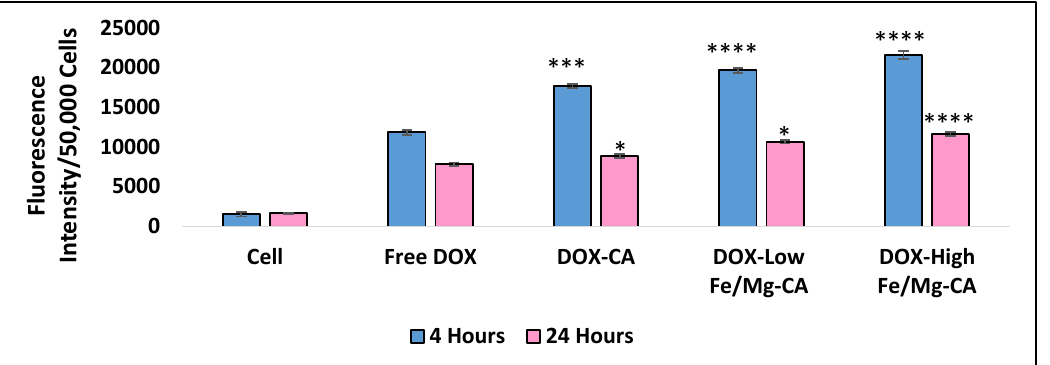
Figure 15. Fluorescence intensity measurement of free DOX, DOX-loaded low Fe/Mg-CA, DOX-loaded high Fe/Mg-CA and DOX-loaded CA particles in MCF-7 cells after 4 h and 24 h of treatment. Results were considered significant at p-value 0.01–0.05 (*), highly significant at p-value 0.0001–0.001 (***) and extremely significant at p-value ˂ 0.0001 (****). P values were calculated with respect to control (DOX in media) and treatment (DOX bound NPs). The confidence interval was 95% for the respective samples. Table 6. Cellular uptake (%) of free DOX, DOX-loaded CA, DOX-loaded low and high Fe/Mg-CA NPs in MCF-7 cells after 4 h and 24 h of treatment.